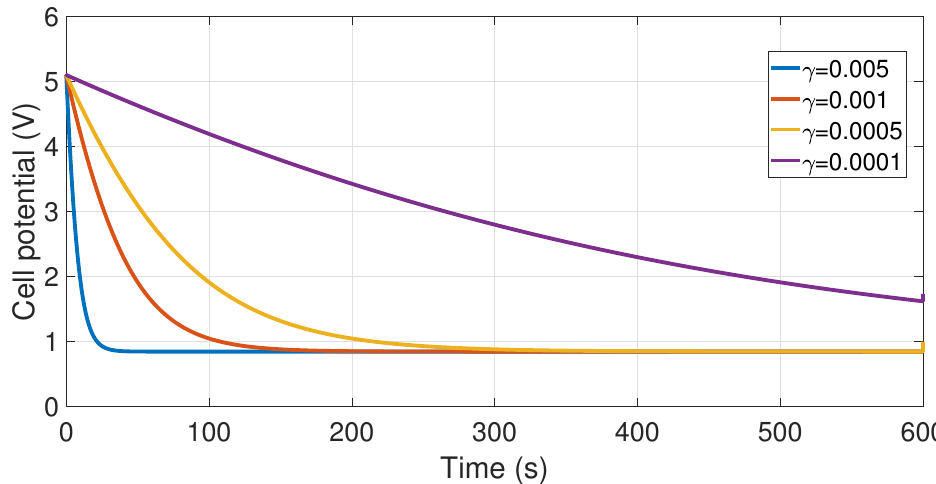
Figure 8. Simulation of potential stability with different values γ .